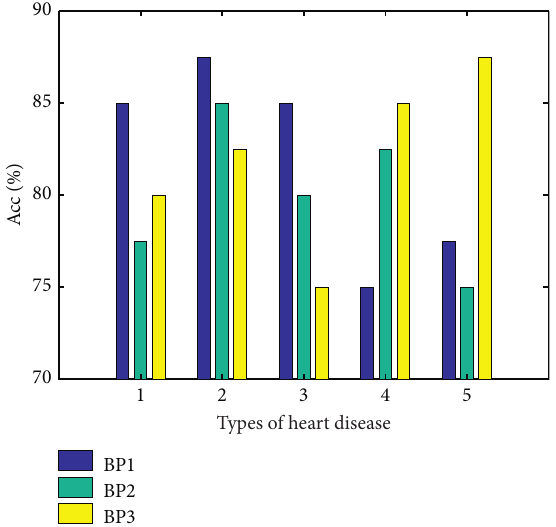
Figure 8: BPNN heart disease recognition rate.